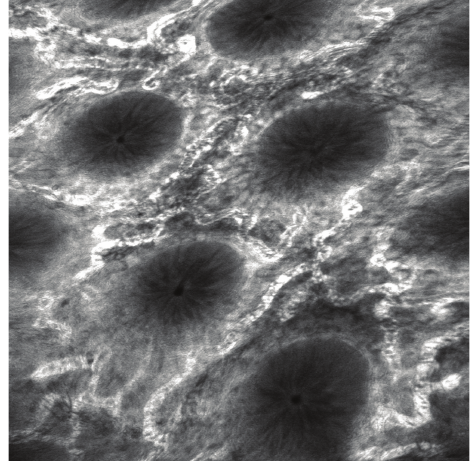
Figure 5: Confocal laser endomicroscopy reveals normal appearing microvessels within the lamina propria and colonic crypts regular in size and shape in patient with quiescent Crohn’s